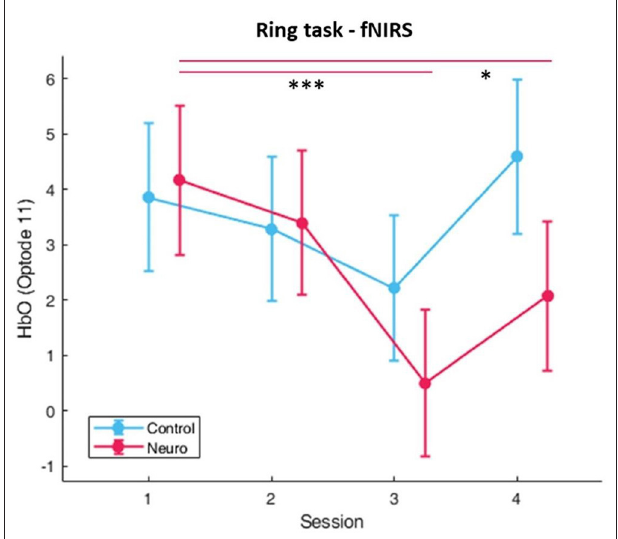
FIGURE 15 | Oxygenated hemoglobin changes over time corrected with level covariate. Significance found between groups, session, and interaction, as well